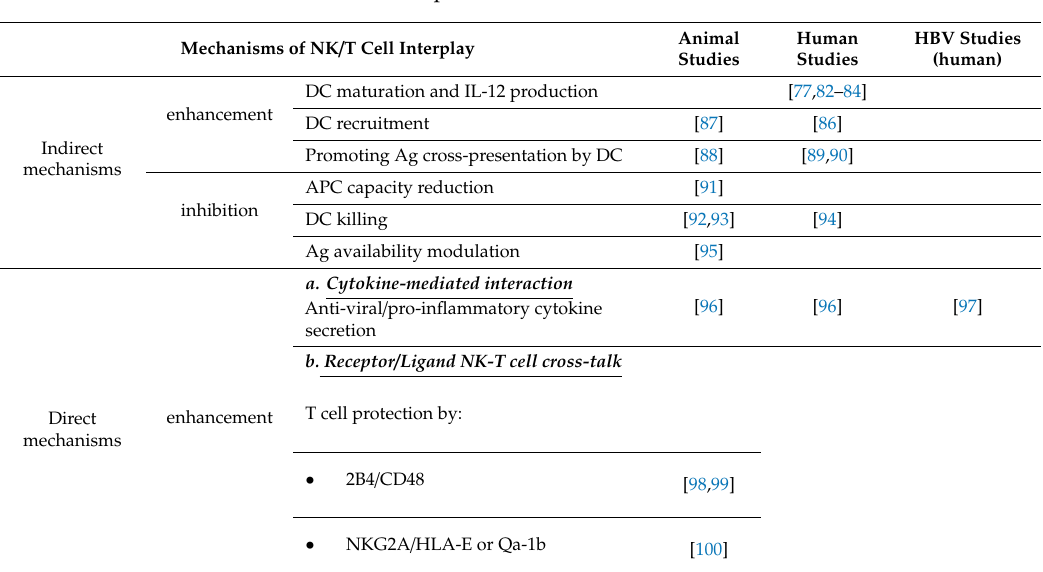
Figure 2. NK / T cell interplay. NK cells can exert either a regulatory or a protective role on T cells via indirect or direct mechanisms. Among indirect interactions, NK cells can influence T cells by regulating dendritic cells (DC), which are responsible for antigen presentation and subsequent T-cell activation. IFN- γ produced by NK cells enhances DC maturation, recruitment, and secretion of IL-12, which, in turn, stimulates T-cell responses. Moreover, NK cells are responsible for the migration of di ff erent immune cells through chemokine production. Interaction between NK receptors and their ligands on DC can induce an enhanced antigen presentation capacity, by upregulating DC MHC and costimulatory molecule expression, but can also lead to immature DC lysis, with an antigen release for cross-presentation by DC subsets. NK cells can also directly promote or restrain T-cell responses through IFN- γ or IL-10 release, respectively. Depending on the balance expressed by the di ff erent receptor / ligand pairs, NK-T cell cross-talk can result in inhibition or induction of T-cell lysis. Table 2. Mechanisms of NK / T cell interplay. Indirect and direct mechanisms of NK / T-cell interaction are summarized and divided based on the resulting T-cell response enhancement or inhibition. References relative to human or animal studies are